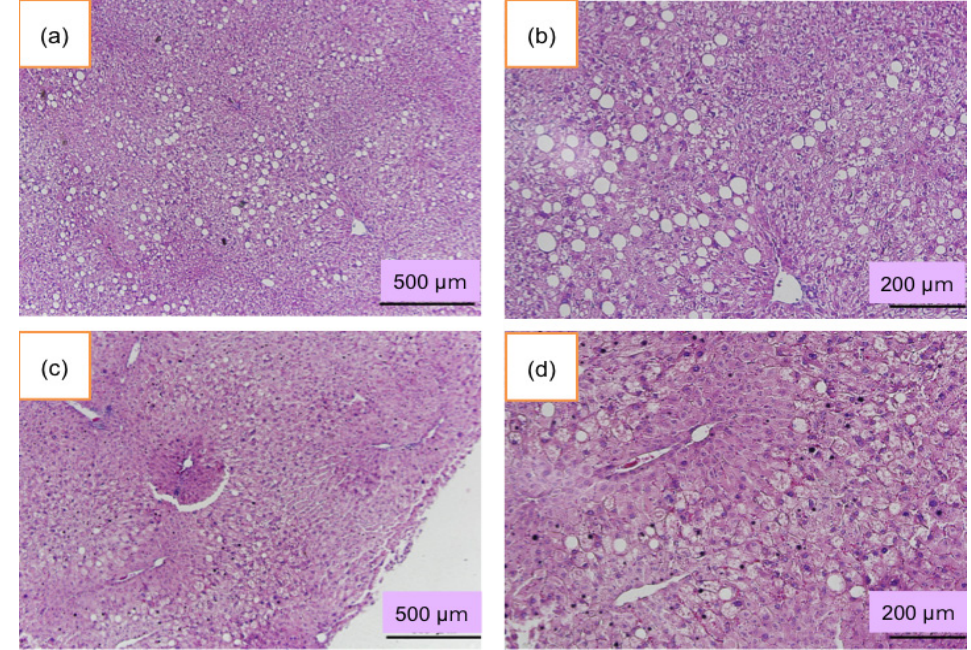
Figure 6. Lipid accumulation in PHT rabbit liver. ( a ) and ( b ): 12-month old PHT rabbits. ( c ) and ( d ): 33-month-old PHT rabbits. ( b ) and ( d ) are enlarged pictures of ( a ) and ( c ),